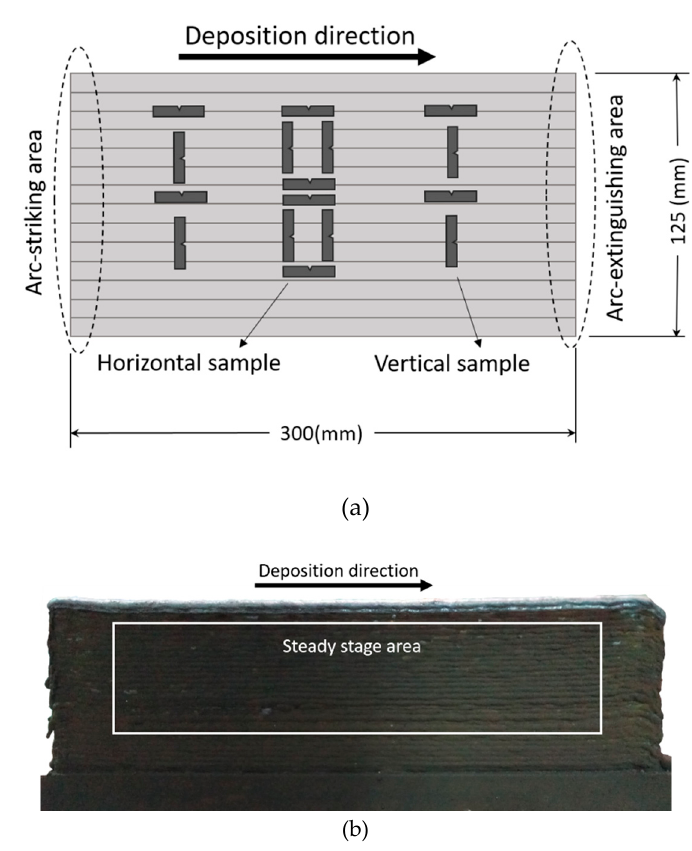
Figure 1. ( a ) Schematic representation of the robot-assisted welded thin wall, highlighting important areas and the direction of specimen extraction. ( b ) An as-built wall with depiction of the steady stage from where samples were extracted for this study.